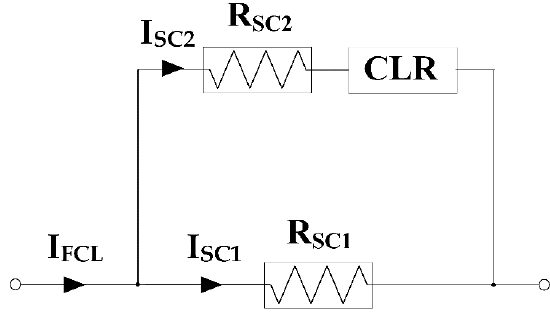
Figure 1. Configuration of the DC superconducting fault current limiter (SFCL).